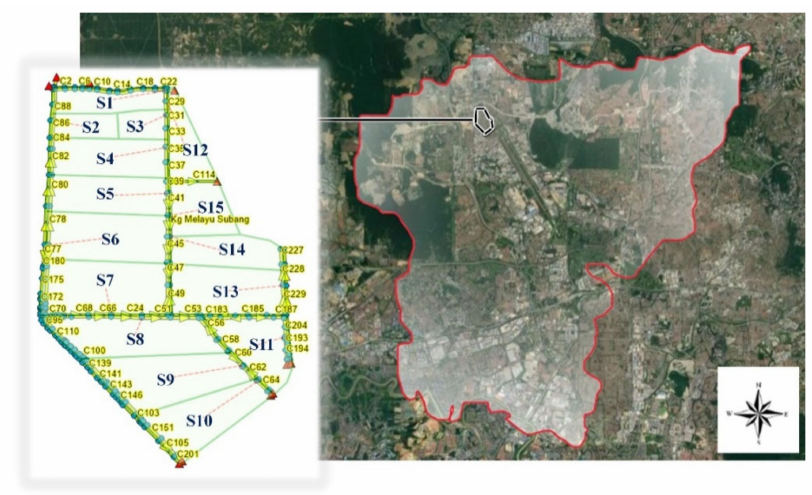
Figure 5. Catchment discretization for 1-D–2-D drainage overflow